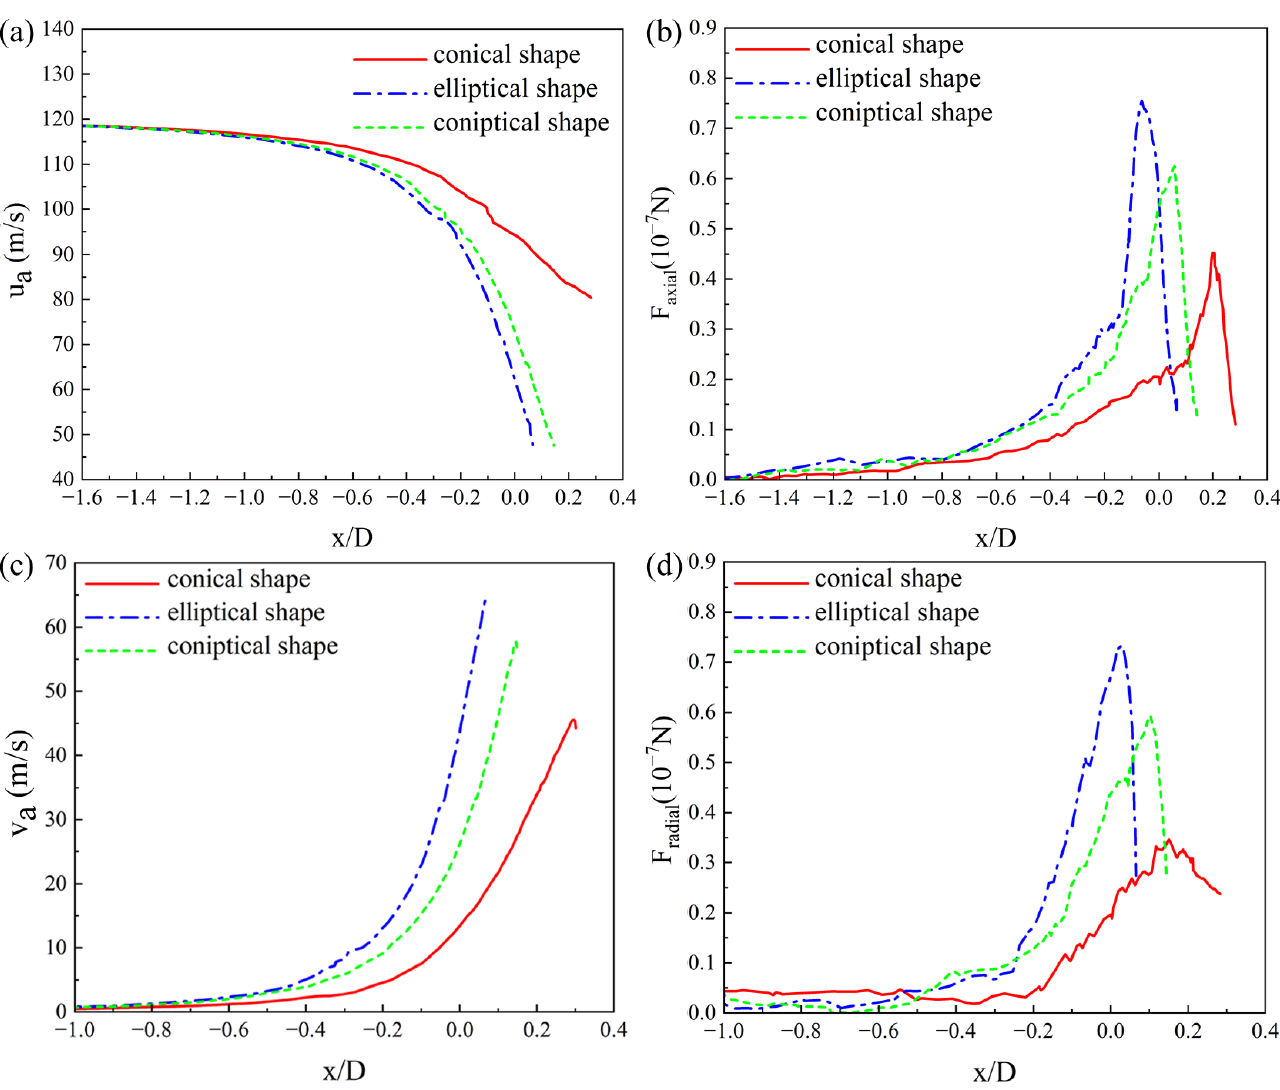
Figure 7. Aerodynamic force analysis of water droplets at 𝑟/𝑅 = 0 . ( a ) Axial velocity of air 𝑢 𝑎 ; ( b ) axial force of water droplets 𝐹 𝑎𝑥𝑖𝑎𝑙 .